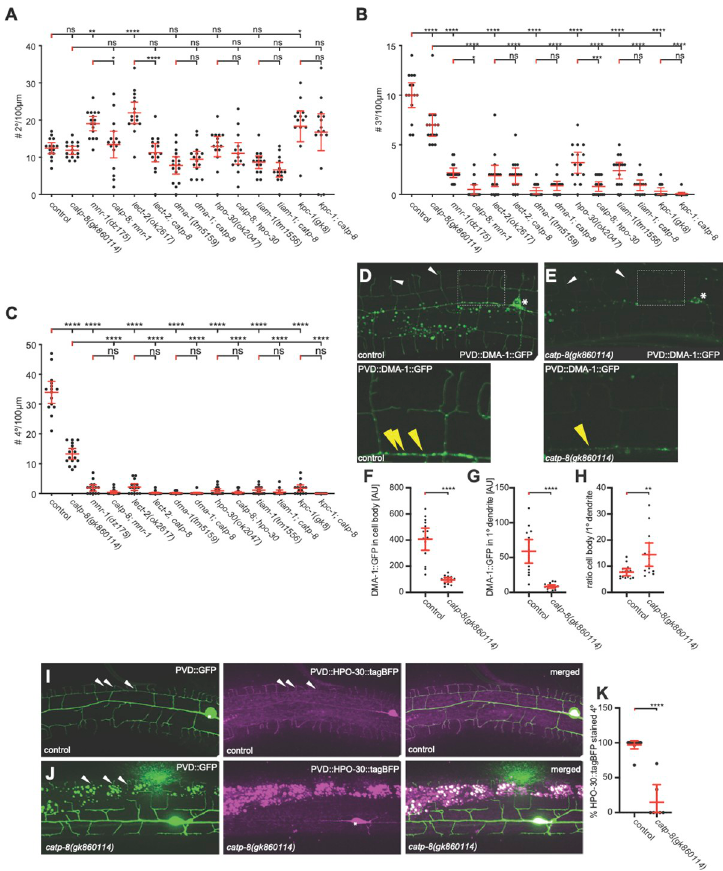
Fig 6. The catp-8/P5A ATPase functions with the Menorin pathway during dendrite patterning. A.—C. Quantification of the number of secondary (A), tertiary (B), and quaternary (C) dendrite branches within 100 μ m anterior to the PVD cell body in animals of the indicated genotypes. Note that all alleles are molecular or genetic null alleles. Data are represented as the mean ± 95% confidence interval. � P < 0 . 05 , �� P < 0 . 01 , ��� P < 0 . 001 , ���� P < 0 . 0001 ns not significant; one-sided ANOVA with Tukey’s multiple comparison test. n = 15 animals per genotype. D.—E. Maximum z-projection of confocal images and magnified inset of DMA-1::GFP expressed in PVD ( qyIs369 ) in a wildtype or catp-8 mutant background, showing a reduction of DMA-1::GFP puncta in the primary dendrite (yellow arrowheads) in mutant animals. Note also the reduction in overall fluorescence in catp-8 mutant animals. F.—H. Quantification of DMA-1::GFP signal in cell body (F), and on the primary dendrite 100 μ m anterior from the cell body (G) in control and catp-8 animals. The signal ratio of cell body to primary dendrite is presented in (H). Data are represented as the mean ± 95% confidence interval. �� P < 0 . 01 , ���� P < 0 . 0001 , Mann-Whitney test. n = 14 animals per genotype. I.—J. Maximum z-projection of apotome images of HPO-30::tagBFP (magenta) expressed in PVD and PVD reporter wdIs52 (green) in control (I) or catp-8 mutant animals (J). Note, that as previously reported [40], overexpression of HPO-30::tagBFP in PVD dendrites results in a reduced number of quaternary dendrites, possibly due to downregulation of DMA-1/LRR-TM. K. Percentage of HPO-30::tagBFP stained quaternary dendrites 100 μ m anterior to the cell body in control or catp-8 mutant animals, presented as mean ± 95% confidence interval. ���� P < 0 . 0001 , Mann-Whitney test. n = 10 animals per